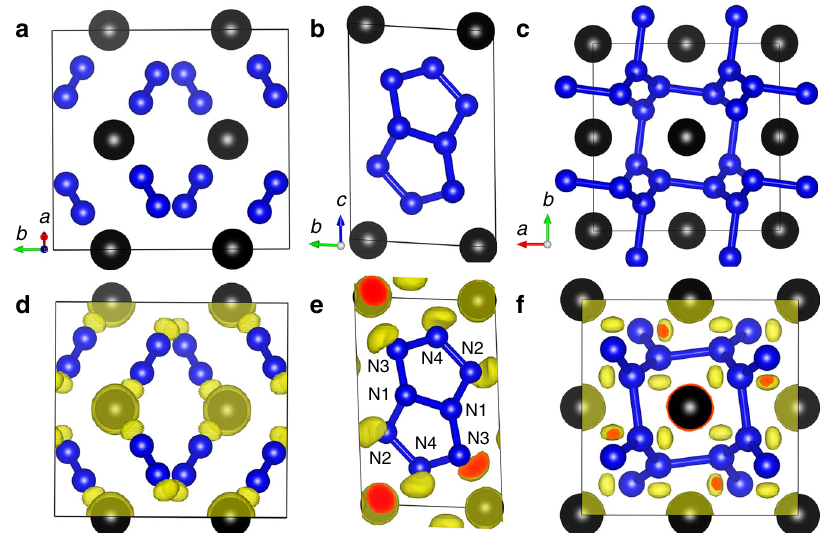
Fig. 2 Crystal structures of HeN 4 . Energetically favorable structures of HeN 4 with space groups C 2/ c ( a ), P 1 ( b ) and I 4 1 / a ( c ). Small blue and large black spheres represent N and He atoms, respectively. Three-dimensional valence electron localization functions with isosurface value of 0.95 for the C 2/ c structure ( d ), and of 0.9 for the P 1 ( e ) and the I 4 1 / a ( f )